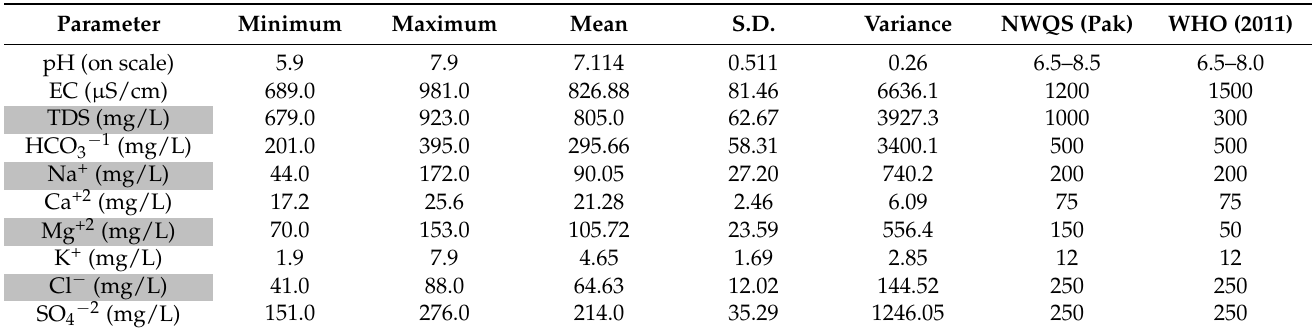
Table 1. Statistical analysis of physicochemical parameters of groundwater samples collected in coastal region of Baluchistan,